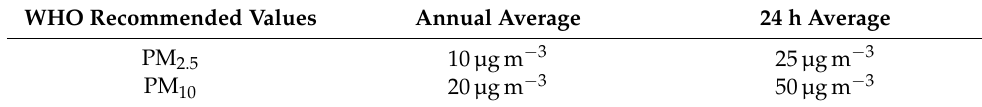
Table 1. Maximum particle levels recommended by the WHO. WHO Recommended Values